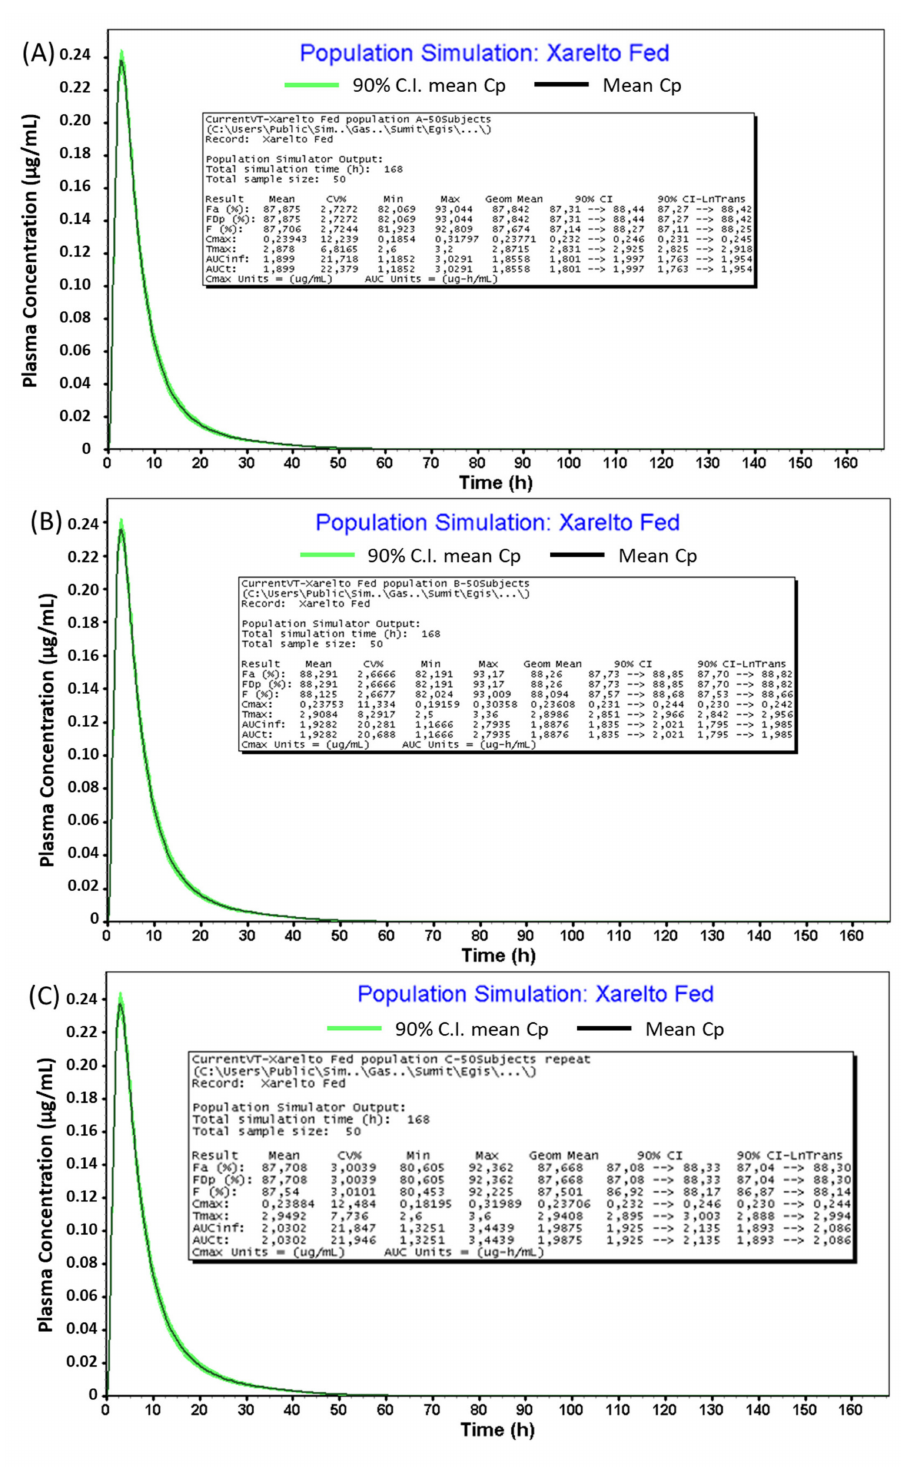
Figure 13. Virtual in vivo pharmacokinetic profile of Xarelto IR tablet (20 mg Strength) for Popula- tions ( A – C ) in fed